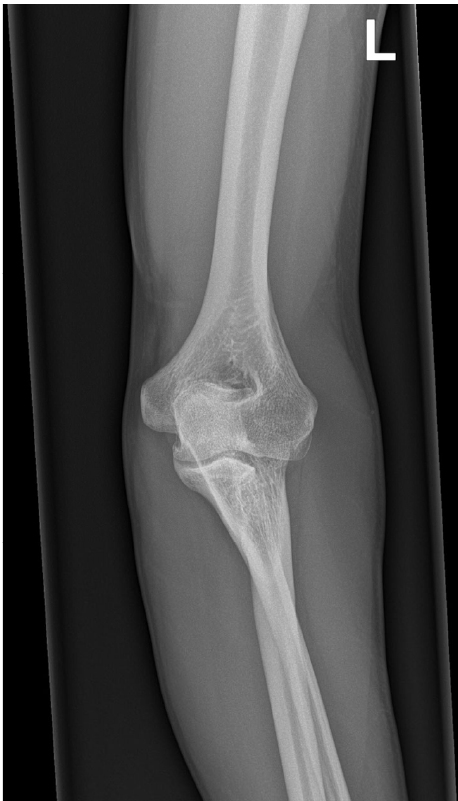
Figure 3. Radiographic image of the elbow joint in antero-posterior view showing Cleary–Omer Type III PRUS.